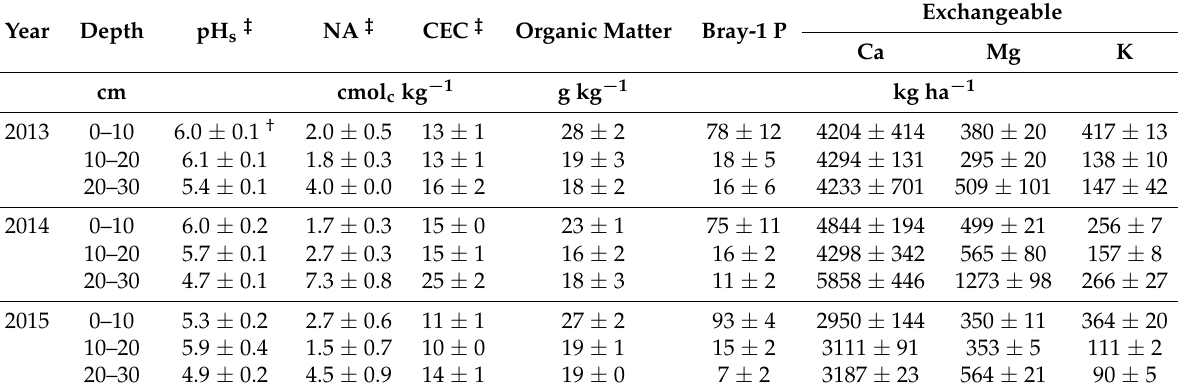
Table 1. Selected initial soil properties by depth in 2013, 2014 and 2015. Data were averaged over three